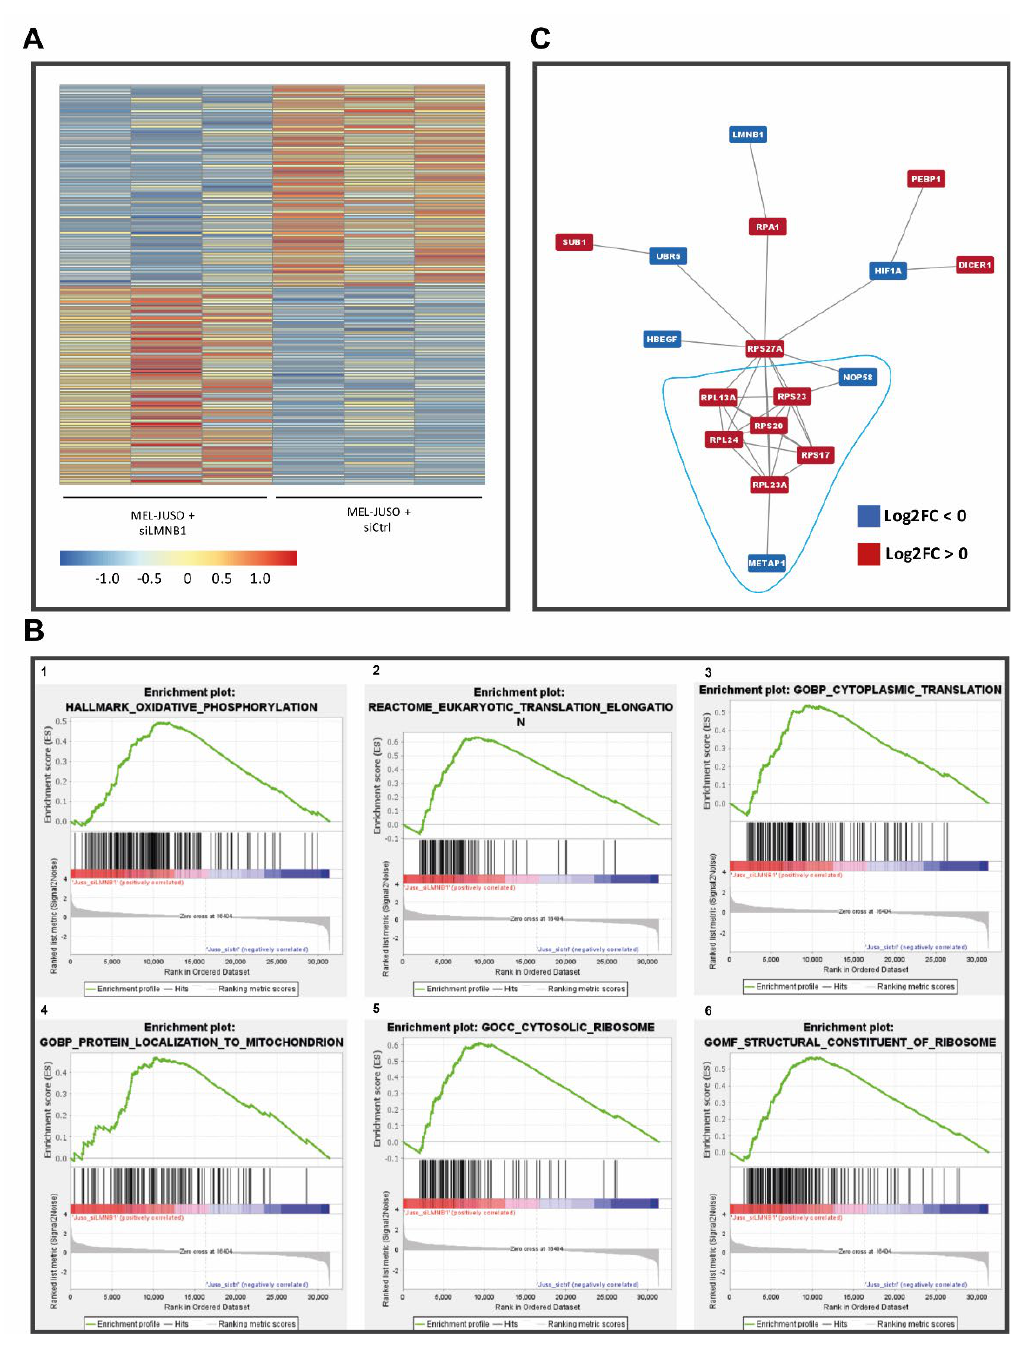
Figure 4. ( A ) Heatmap of differentially expressed (adj. p < 0.1) genes upon siLMNB1. ( B ) Enrichment plots (FDR < 25%) illustrating the profile of the running enrichment score (green) and positions of the enriched gene sets and the rank-ordered list of genes differentially expressed in MM cells treated with siLMNB1 and siCtrl, respectively, identified by GSEA. Genes upregulated in siLMNB1 MM cells are shown on the left side of the graph in red, downregulated ones—on the right side in blue. (C) Biggest network of protein–protein interactions (PPIs) of possibly expressed gene products from the differentially expressed genes (red: log2FC > 0; blue: log2FC < 0). Enrichment analysis showed a putative relevance of these protein networks in translation and ribosome formation, partially under stress conditions.